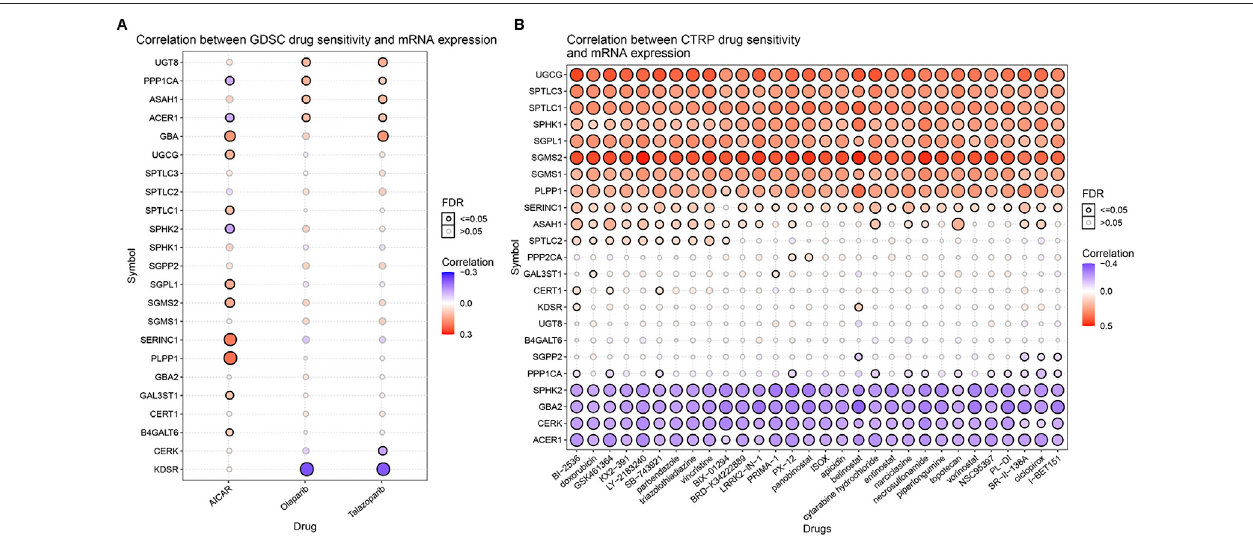
FIGURE8| ThecorrelationsbetweenthemRNAexpressionofsphingolipidgenesandthedrugsensitivityofGDSCandCTRP. (A) ThecorrelationbetweenmRNA expression and GDSC drug sensitivity. The solid spheres represent p < 0.05, and the dotted spheres represent no statistical signi fi cance. The larger the sphere, the higher the correlation. In the color bar on the right side, red represents increased mRNA expression, and blue represents decreased mRNA expression. (B) The correlation between mRNA expression and CTRP drug sensitivity. The solid sphere represents p < 0.05, and the dotted sphere represents no statistical signi fi cance. The larger the sphere, the higher the correlation. In the color bar on the right side, red represents increased mRNA expression, and blue represents decreased mRNA expression.